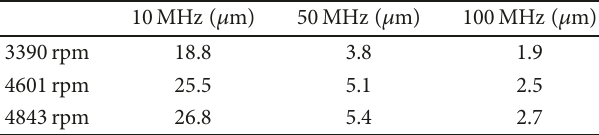
V 1 in green and 2 in orange). Table 1: Achievable de fl ection resolutions ( μ